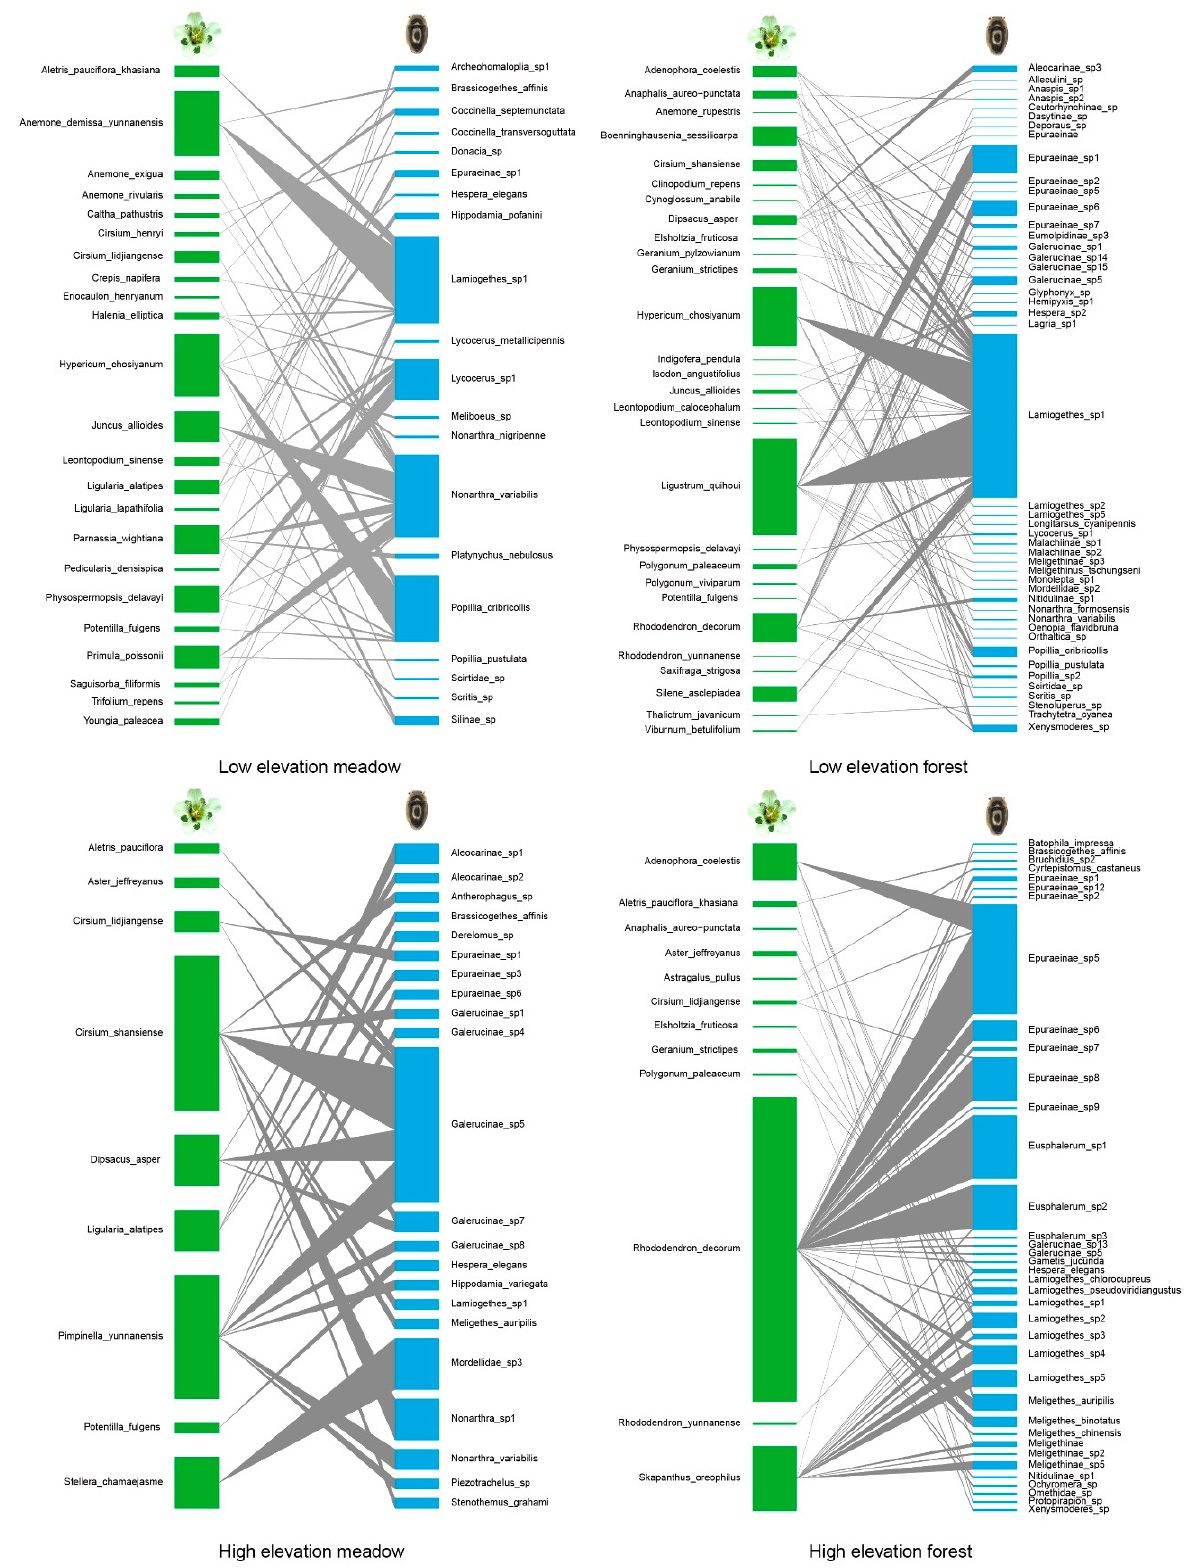
Figure 3. Four networks representing plant and their flower visiting beetles. Green left side = plant species and blue right side = beetles. High elevation, LB; low elevation, YH.